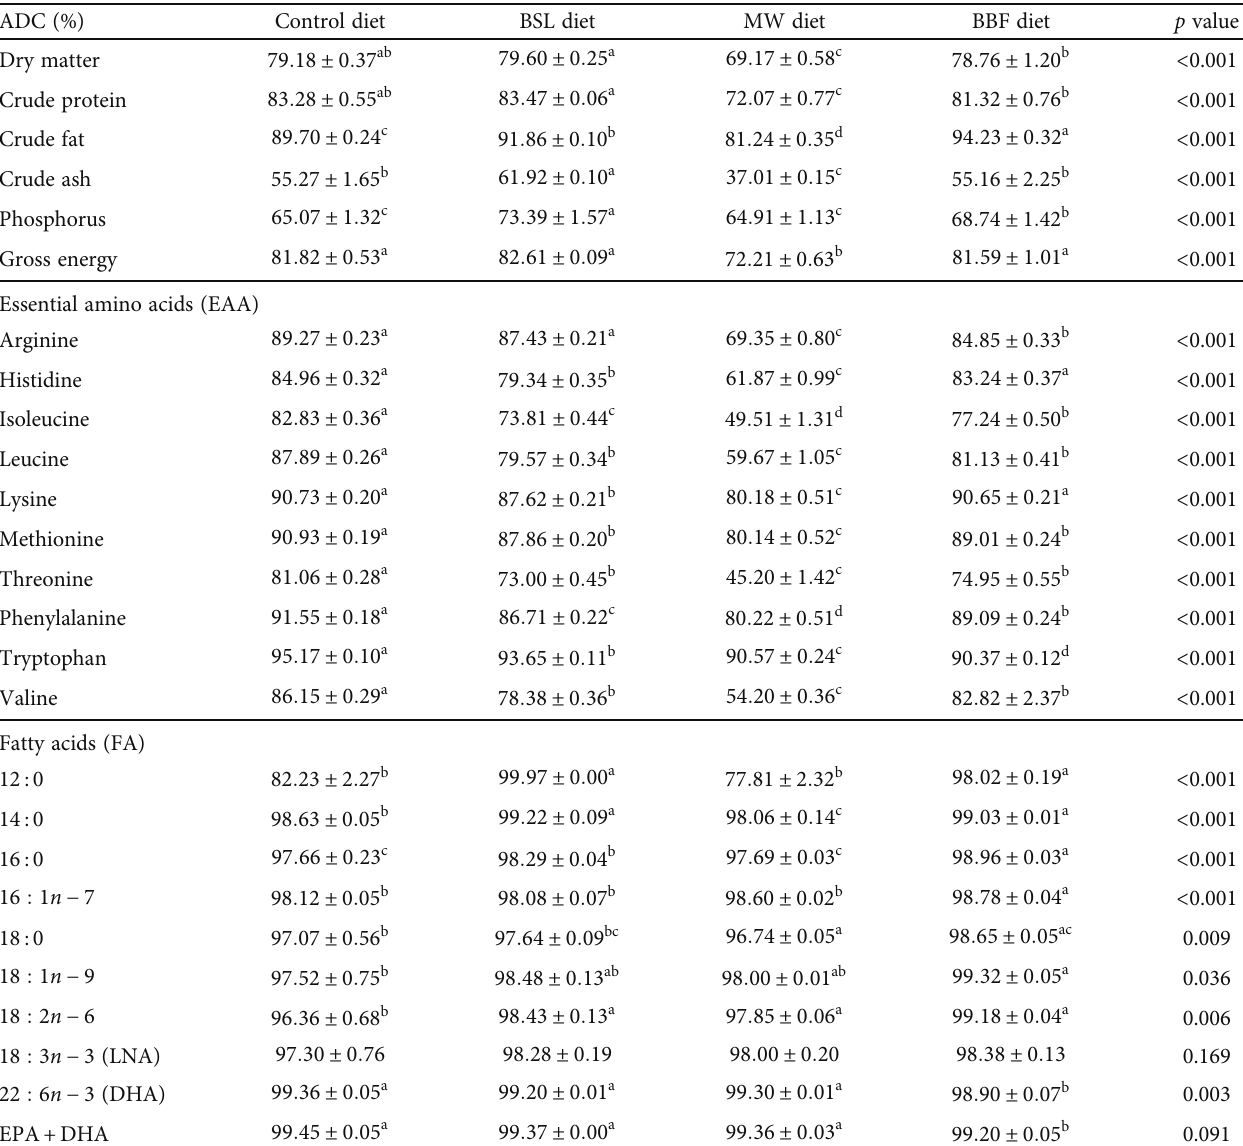
Table 3: Apparent digestibility coe ffi cients (ADC) of the diets prepared by using di ff erent insects as test ingredients. ADC